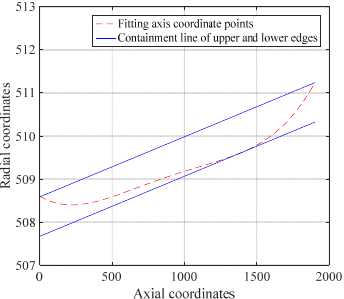
Figure 17. Graph of straightness deviation evaluation results.